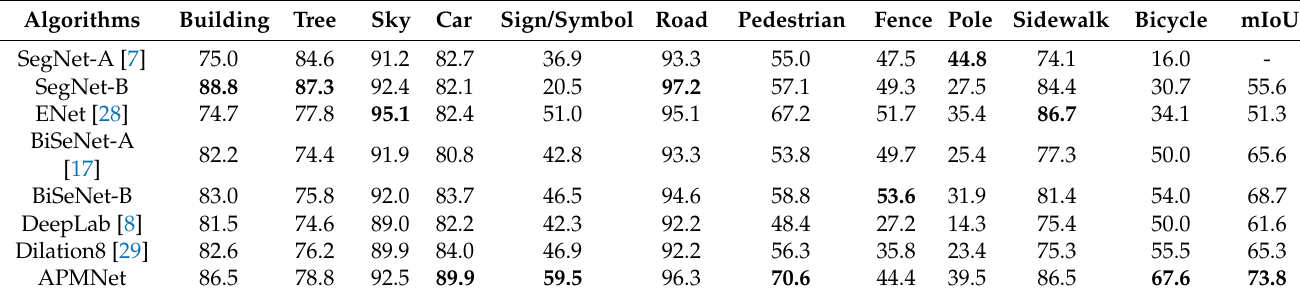
Table 4. Results with CamVid; “-” indicates that the results were not given in the original paper. The bold results indicate the best for the classes.